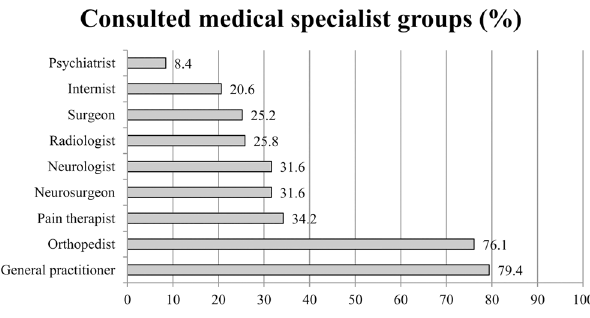
Fig 2. Consulted medical specialist groups in percent